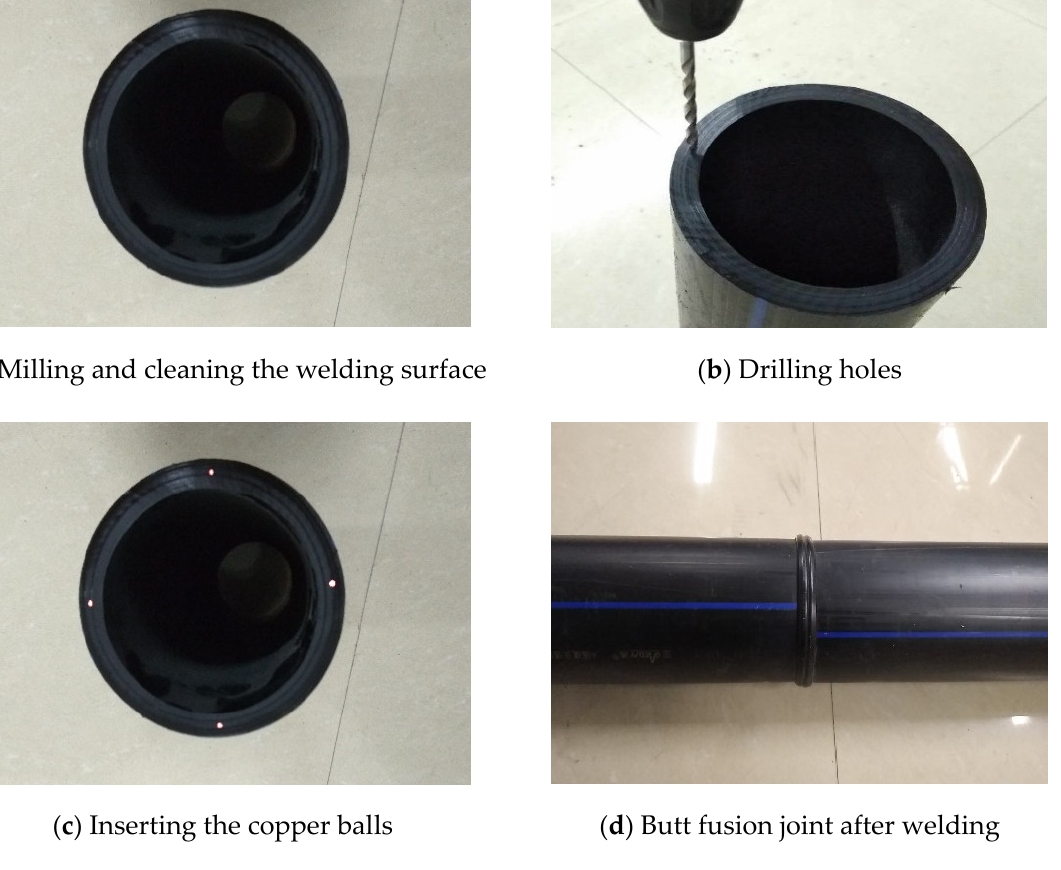
Figure 1. Process of inserting defects into the butt fusion joint of HDPE pipes. Table 2. The defect diameter, wall thickness, defect ratio and creep life of the